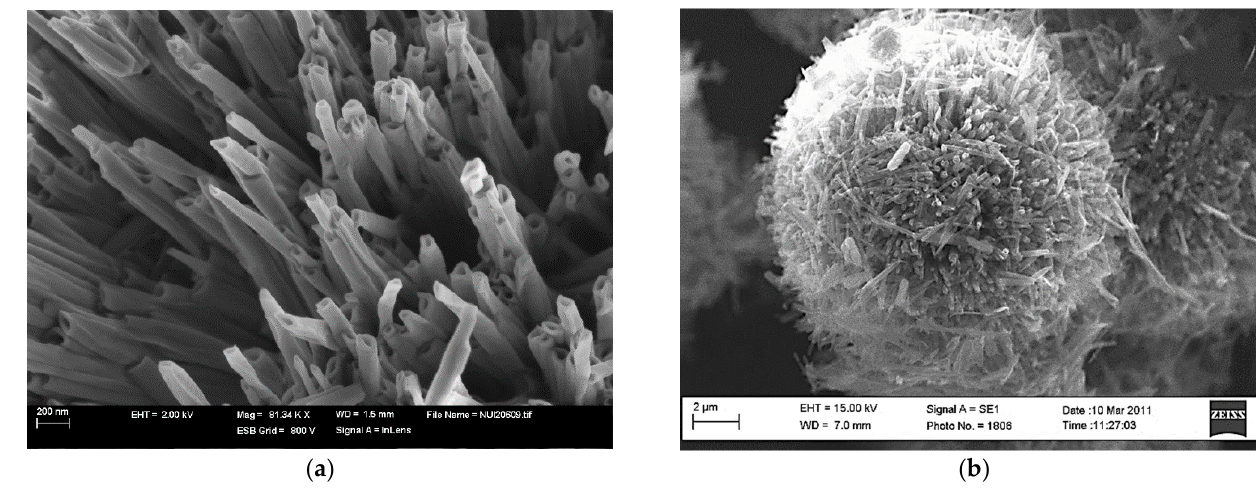
Figure 5. SEM Micrographs vanadium oxides: ( a ) nanotubes, ( b ) center hollowed vanadium oxide nanourchin.